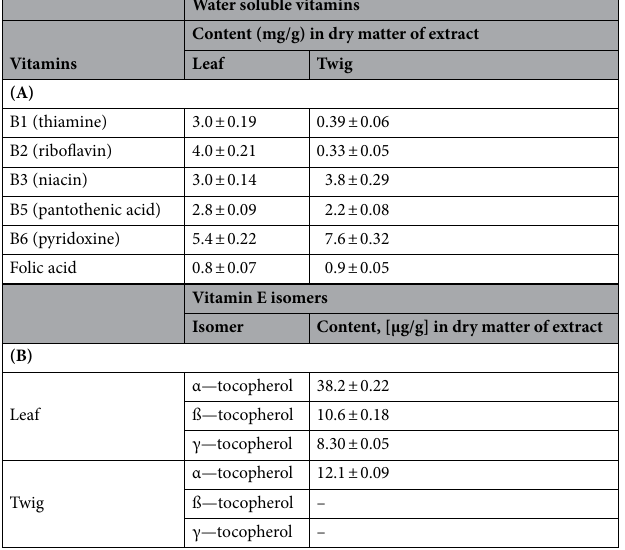
Table 3A. Similar amount of all vitamins analyzed were detected in leaves and twigs. However, the concentrations of vitamin B6 were the highest. Obtained results show that concentration of tocopherol isoforms in the tested plant materials depended of part of plant, moreover, in the case of twig extracts only values for α—tocopherol were detectable (Table 3B). H. rhamnoides twigs contained only the α isoform at 1.21 mg/100 g, which was lower than that in the leaves, in which α, ß and γ isoforms were found at 38.2 μg/g, 10.6 μg/g and 8.3 μg/g, respectively. Antioxidant activity of extracts.